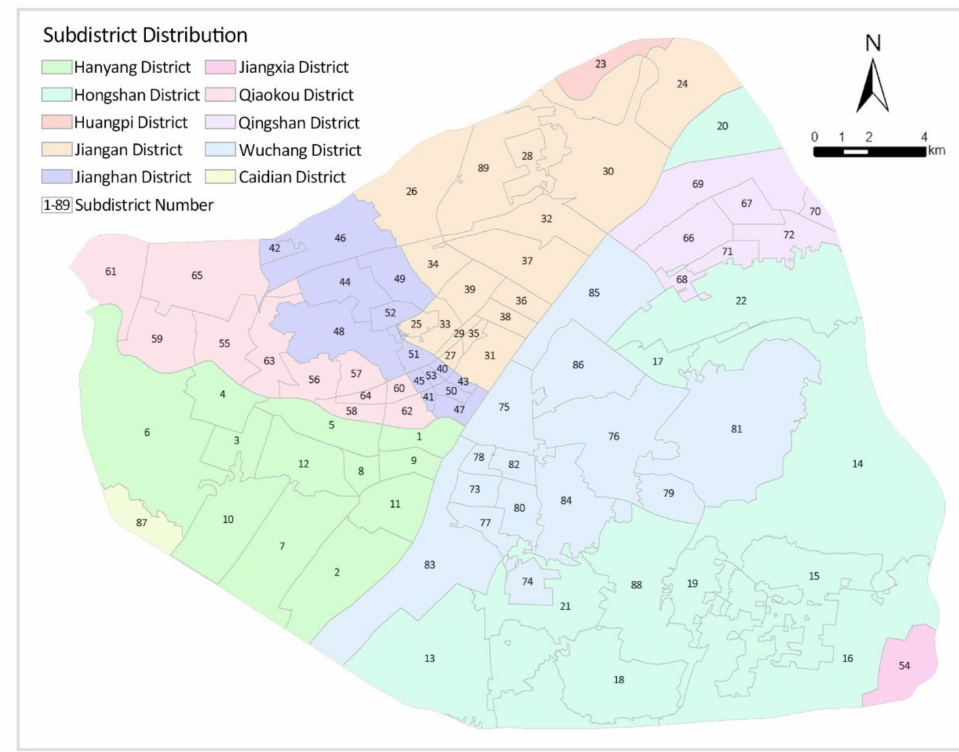
Figure 2. Distribution of subdistricts in the centre of